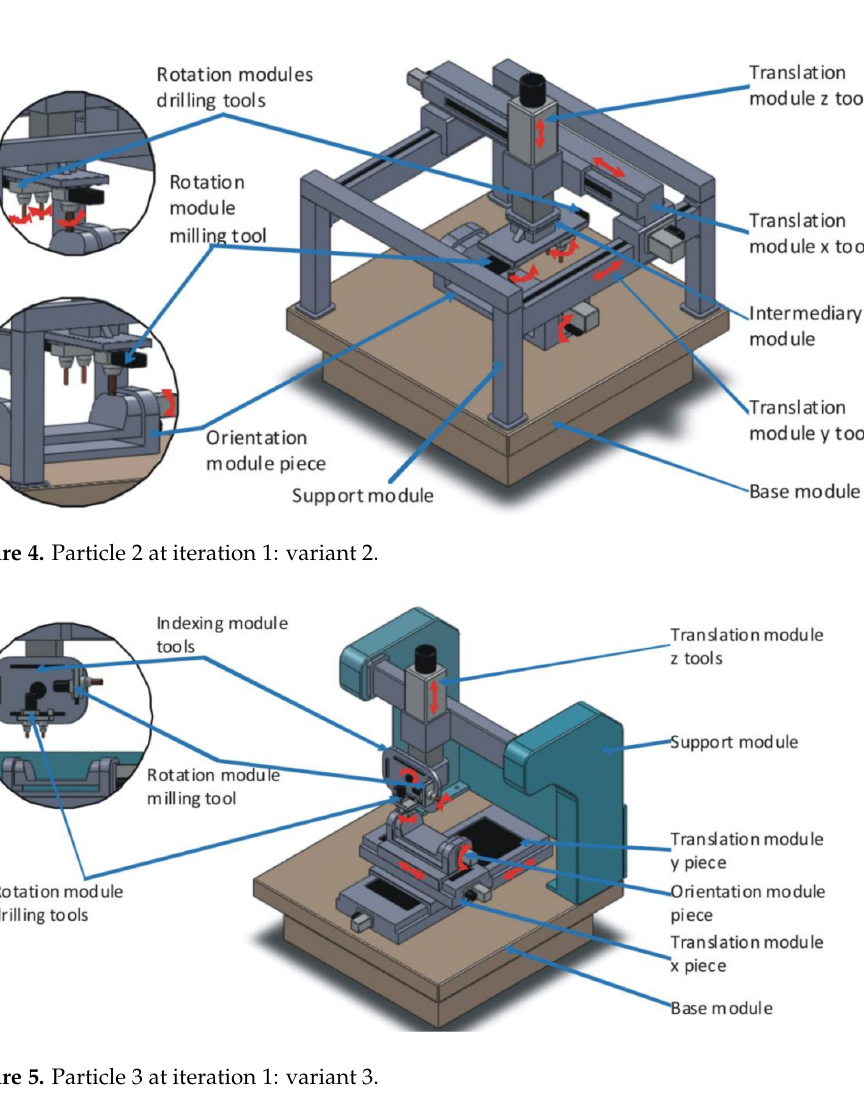
Figure 5. Particle 3 at iteration 1: variant